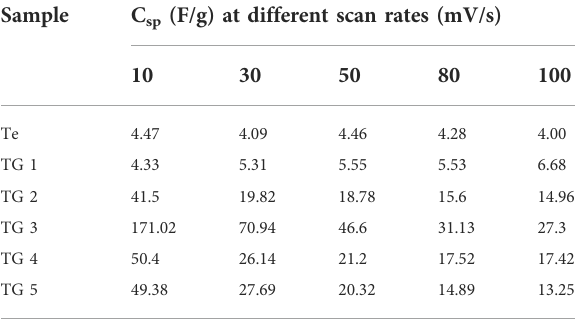
TABLE 2 Raman shift in lower wavenumber. Raman band